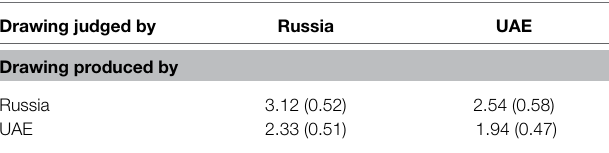
TABLE 1 | Mean judgment scores by each judgment group (Phase II) for the alien creature drawings produced by each production group (Phase I). Drawing judged